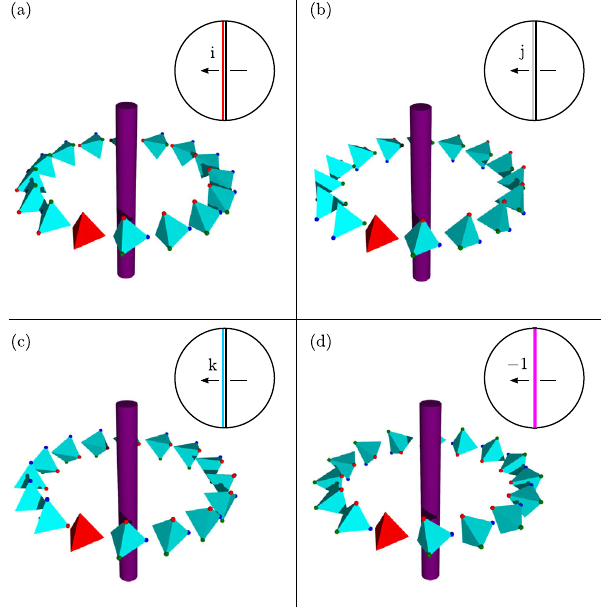
Fig. 2 Diagrams for Q 8 -colored links, I. Instead of labeling the arcs of a Q 8 - colored link diagram by arrows and elements of Q 8 , this information is expressed graphically in terms of three types of bicolored arcs ( a – c ) and one type of colored arc ( d ). An example of the winding of the tetrahedral order parameter fi eld about the core of a topological vortex corresponding to each type of (bi)color is depicted as well. The colored spheres at the vertices of the tetrahedra are not physical data; their purpose is to clarify the winding of the tetrahedral fi eld. The basepoint is marked by a red tetrahedron, and the winding direction is anticlockwise. Clockwise winding corresponds to the inverse element in the group Q 8